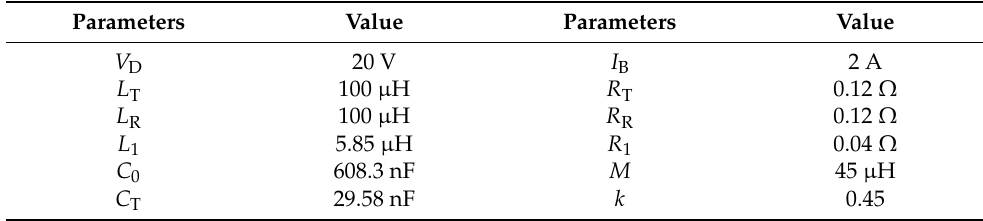
Table 2. Theoretical circuit parameters of the proposed CLC/N compensated WPT system.